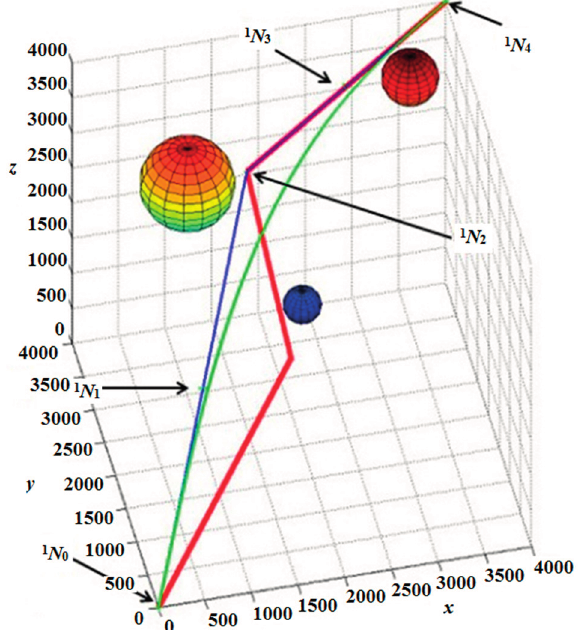
Figure 12. Results of path planning via the multi-RRT and improved A-star algorithms and the finalized path after introducing Bezier curves in Case 1 (unit: